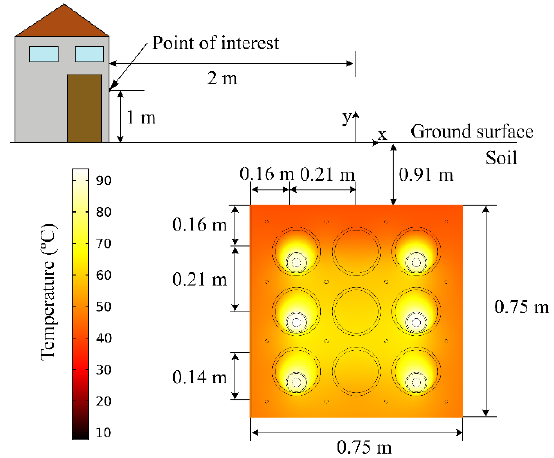
Figure 10. Temperature distribution in shielded cable duct bank.